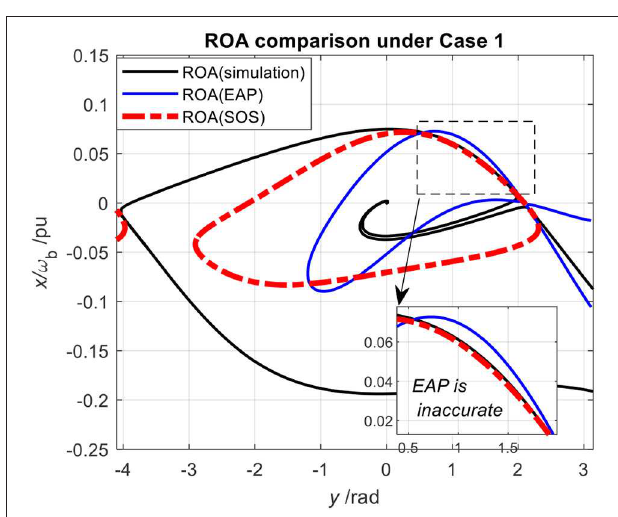
FIGURE 5 | ROA comparisons under a weak grid condition ( α pll = 10, I ref cd = 1, k scr =